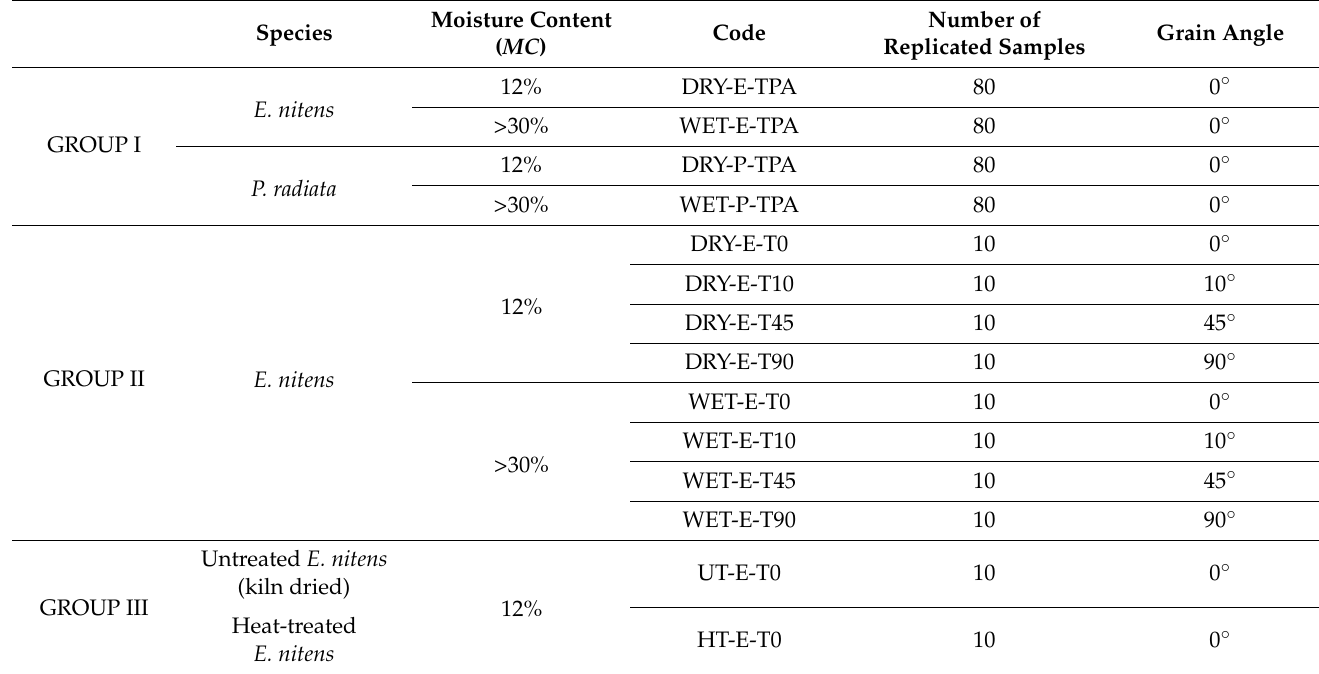
Table 1. Summary of